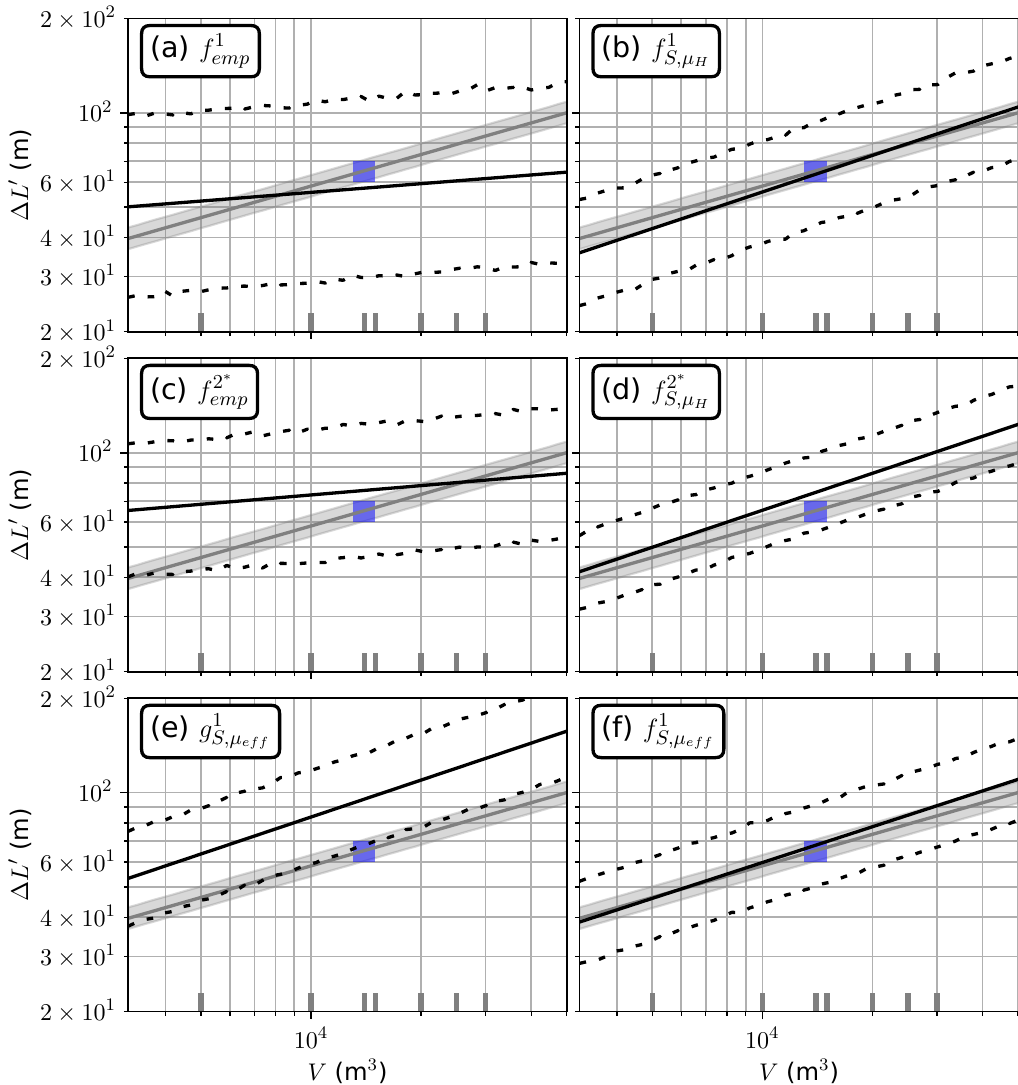
Figure A5. Travel distance estimated from volume for the Fei Tsui Road case study, and a variation of DB2 with only debris flows, debris avalanches and debris slides. The corresponding travel distance estimations are marked with the super-script 2 ∗ . Notations are otherwise the same as in the main body of the article. Green and blue rectangles: estimations of volumes and travel distances for the 2009 and 2018 collapses, respectively. Grey line: Numerical estimation from back-analysis ( f fit ), S = tan ( 26 ◦ ) = 0.49. The grey area is the upper and lower limits of the with µ S = tan ( 13.5 ◦ ) = 0.24 µ fit S 95% prediction intervals derived for µ S = tan ( 13.5 ◦ 2 ◦ ) . ( a ) Estimation with f 1 emp . ( b ) Estimation ± with f 1 . ( c ) Estimation with f 2 ∗ emp . ( d ) Estimation with f 2 ∗ . ( e ) Estimation with g 1 . ( f ) Estimation S , µ H S , µ H S , µ eff with f 1 . Black lines are direct estimates, dashed lines give the 95% prediction S , µ eff